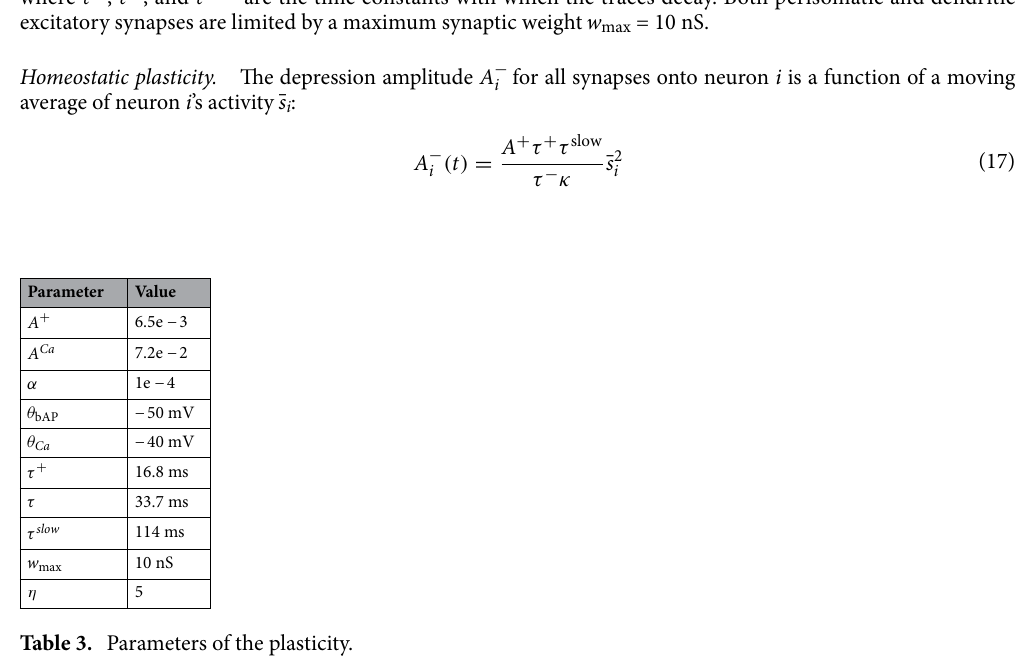
Table 3. Parameters of the